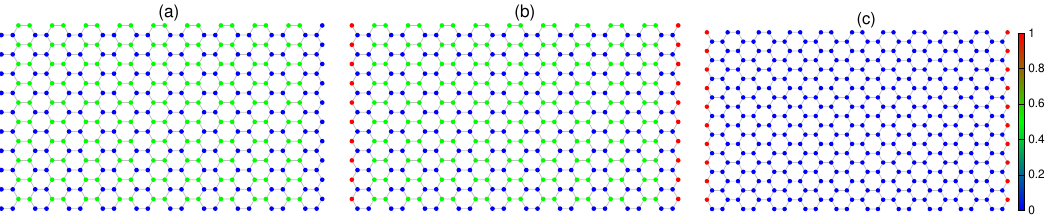
Figure 8: Local density profile of a 20 × 20 honeycomb lattice under open boundary = 6, t = 1 and β = 120, corresponding to: condition along x -direction with W 0 (a) µ = − 6.5 in the lower plateau, (b) µ = − 5.8 in the upper plateau, and (c) the difference between densities of (b) and